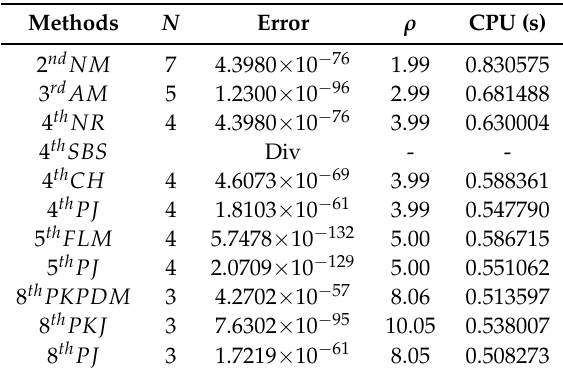
Table 4. Comparison of results for Application 1.